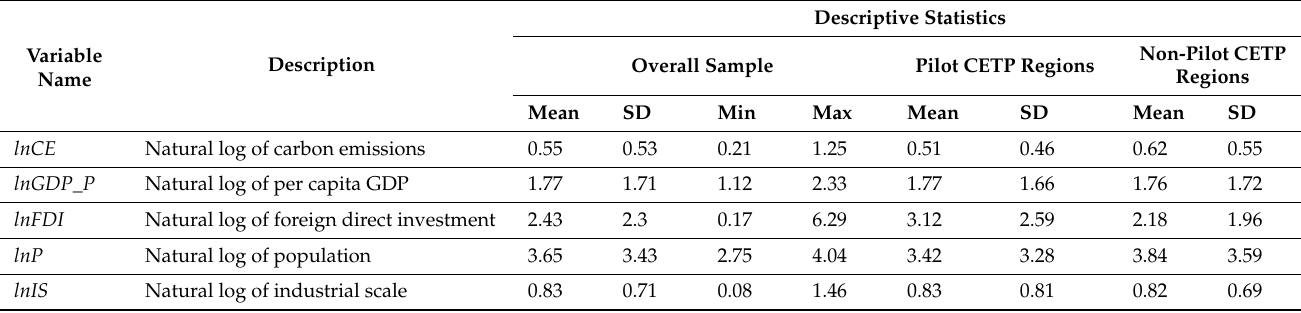
Table 1. Variables used in the DID model and their descriptive